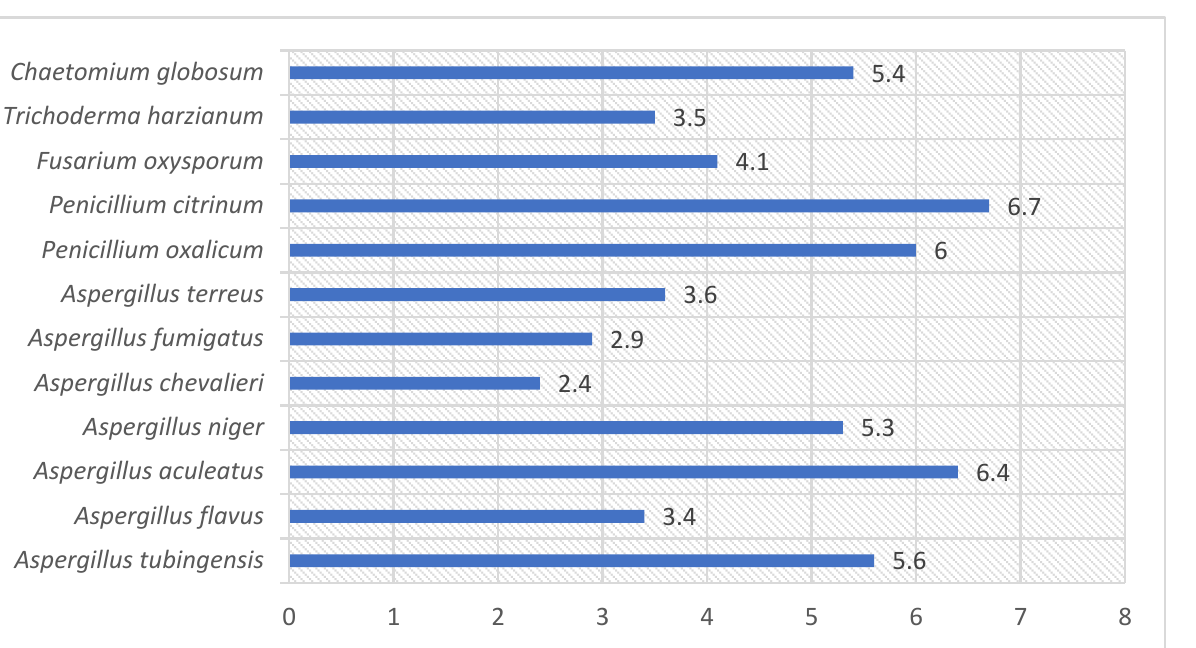
Table 4. The IAA production under different concentrations of tryptophan at different pH levels.